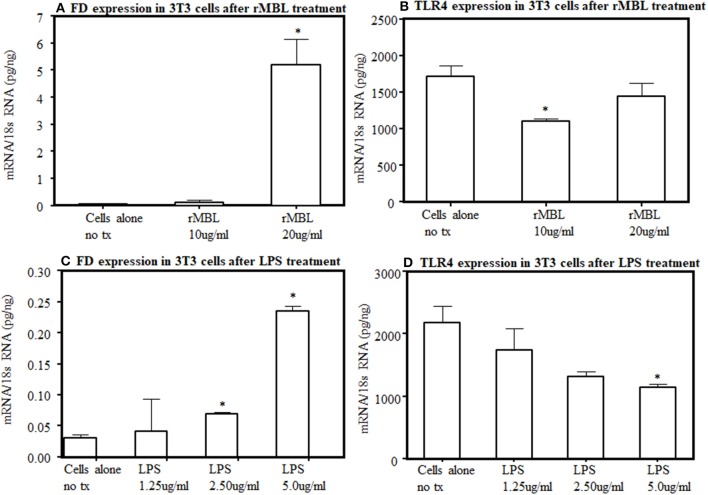
Effect of human rMBL or human rTLR4 on FD expression on differentiated 3T3-L1 cells at 48 h. (A) rMBL increased FD expression in a dose-dependent manner. (B) rMBL also effected the TLR4 expression. (C) LPS also increased FD expression dose-dependent manner. (D) LPS also decreased TLR4 expression with increasing doses. Data are shown as Mean ± SEM of three replicative experiments. *p < 0.05 considered significant.